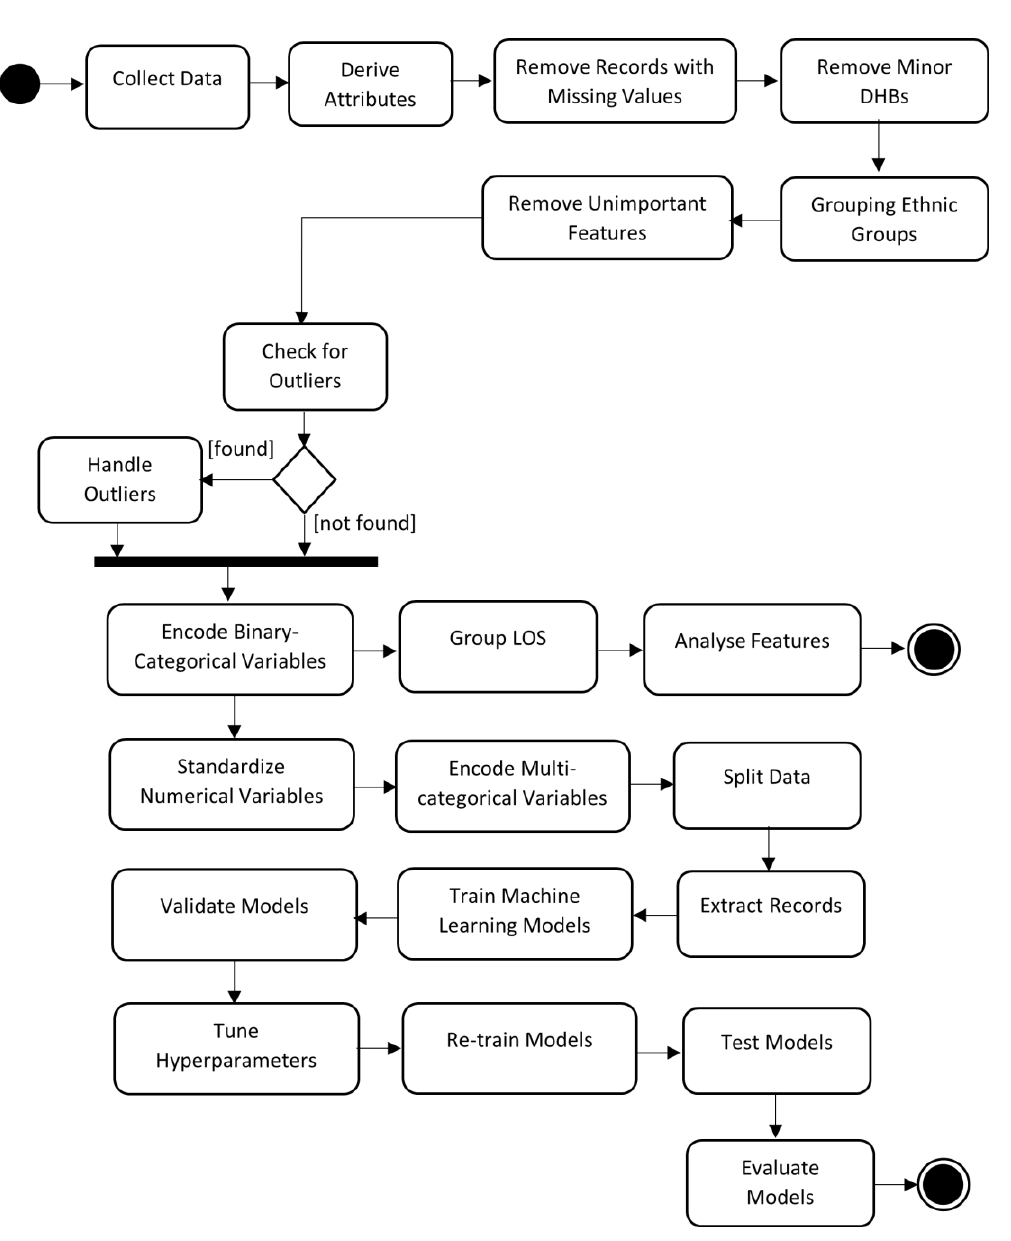
Figure 1. Activity diagram for feature analysis and machine learning model development method- ology.